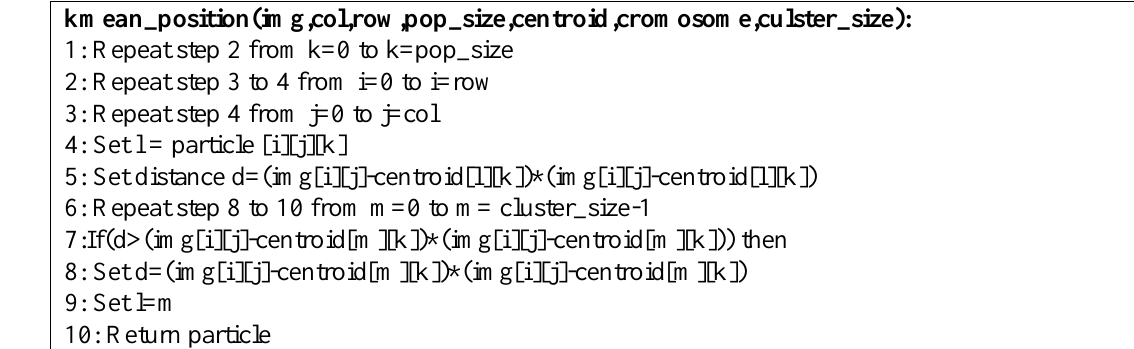
Algorithm 8. The K-means algorithm is used to find the current position of a particle. kmean_position(img,col,row,pop_size,centroid,cromosome,culster_size):